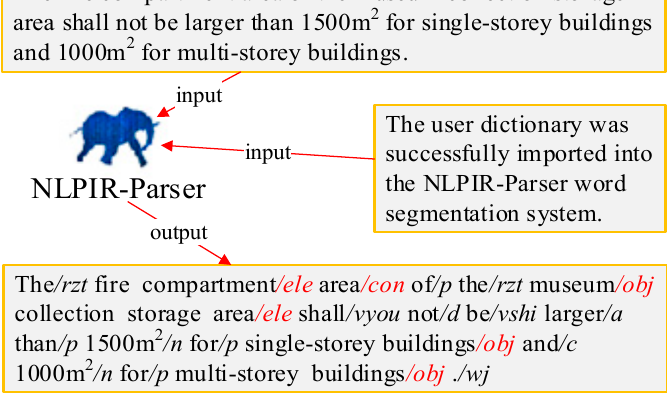
Figure 3. Text segmentation using the user dictionary.